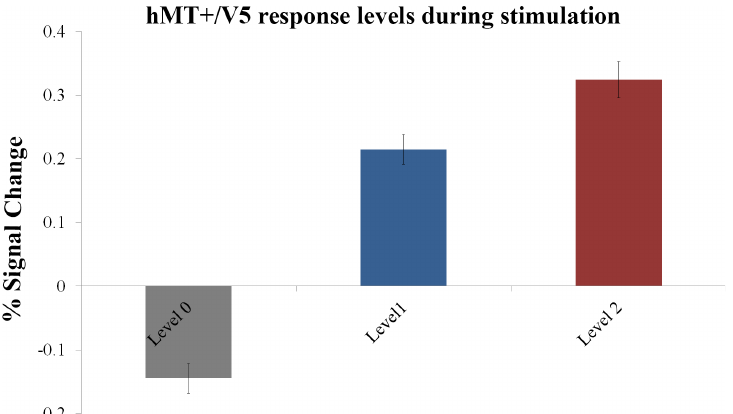
Fig 3. Mean BOLD activity within hMT+/V5 ROI during visual motion stimulation at different response levels. Group results for the localizer run, based on mean event-related BOLD response to the three stimulation conditions in the defined ROI per participant. Significant differences between all conditions were found at P < 0.05 (with Bonferroni correction for multiple comparisons). Values are presented as mean ± s.e. m. Level 0 — stationary dot; level 1 — dot with two opposing motions; level 2 — dot with four opposing